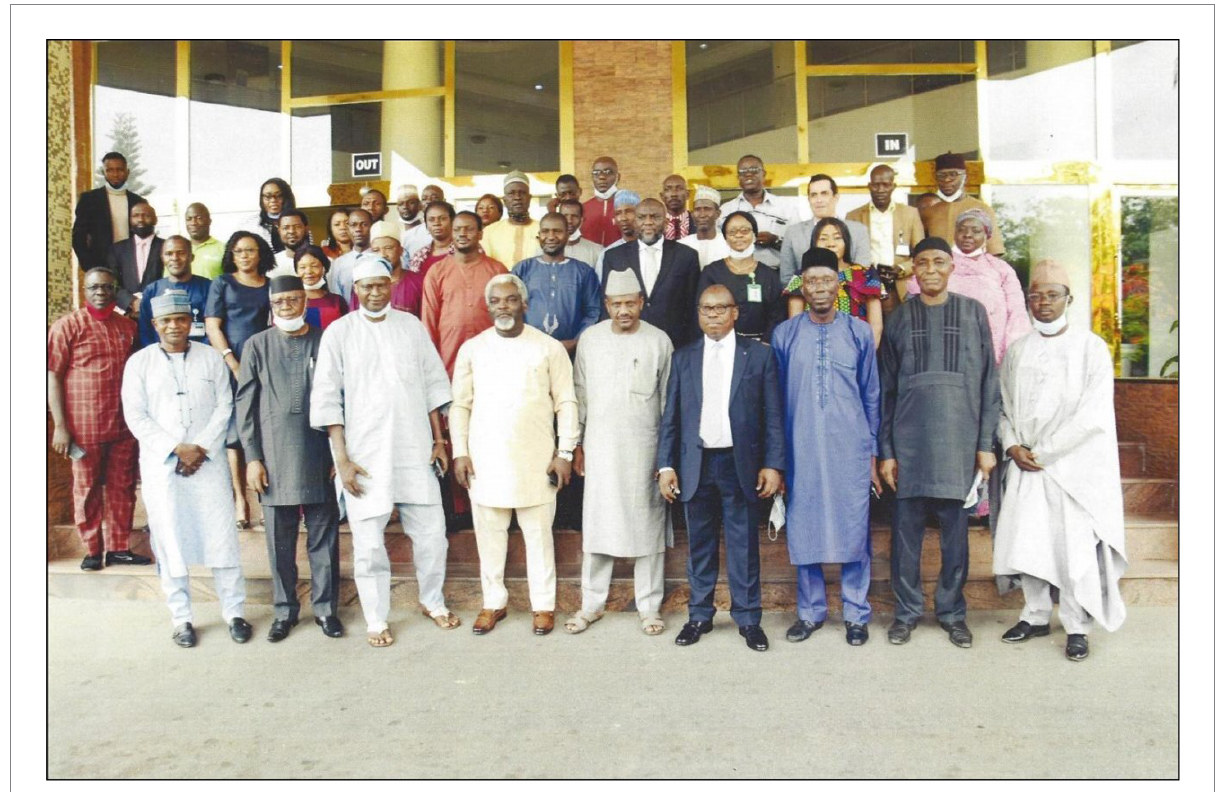
FIGURE 3 Participants of the National Workshop in Abuja, Nigeria. The objective of the workshop was to (i) discuss the effectiveness commercial trials during the CBN-ABP 2020 wet season project, and (ii) discuss the way forward to converge efforts of the different institutions to mitigate aflatoxins in